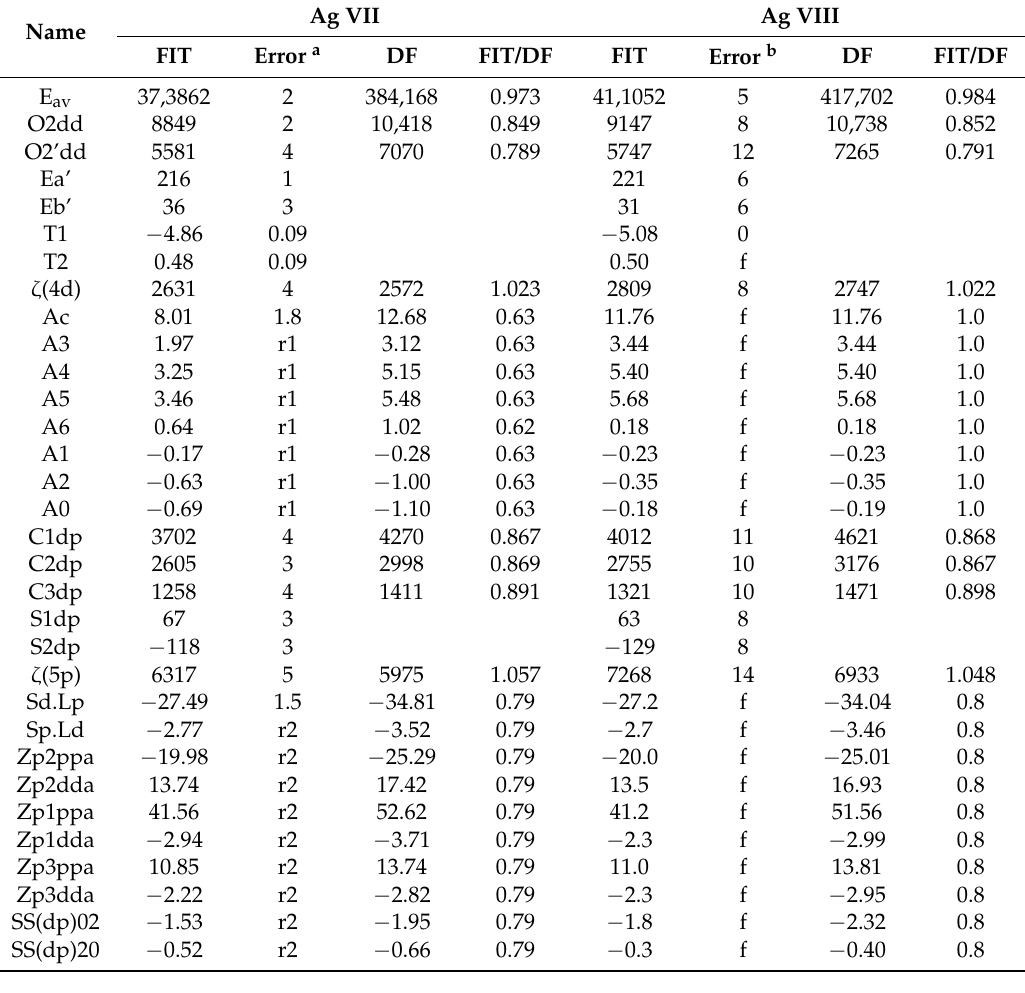
Table A13. Energy parameters (in cm − 1 ) of the 4d 4 5p configuration in Ag VII and 4d 3 5p configuration in Ag VIII calculated by orthogonal parameter technique in comparison with the DF